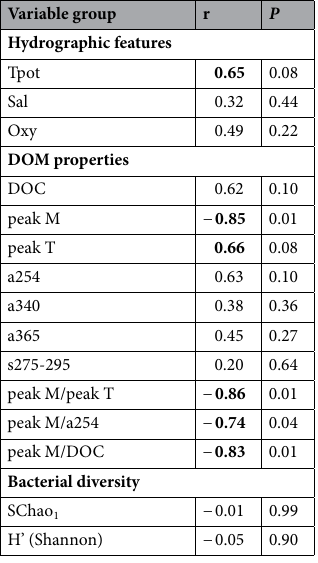
Table 3. Pearson correlation coefficient (r) for the relationship between eCFs and hydrographic features (potential temperature: Tpot; salinity: Sal; dissolved oxygen concentration: Oxy), DOM (dissolved organic carbon concentration: DOC; fluorescence peaks: peak M, peak T; absorption coefficients at 254, 340 and 365 nm: a254, a340, a365; spectral slope between 275 and 295 nm: s275-295) and diversity metrics (ASVs richness estimator: SChao 1 , and Shannon diversity index: H’). Significant correlations ( P < 0.1) are highlighted in bold.